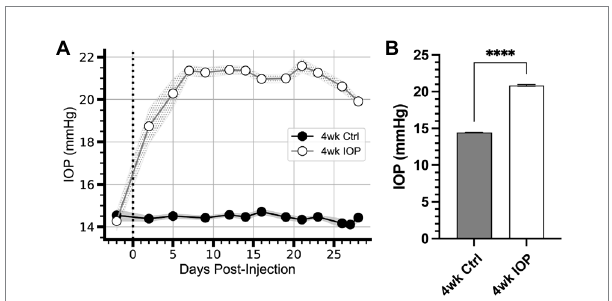
FIGURE 1 IOP elevation due to microbead occlusion of the anterior chamber. (A) Intraocular pressure (IOP) of microbead-injected eyes (4wk IOP) increases rapidly following injection (vertical dotted line) and remain elevated for the duration of the 4 weeks. The IOP of saline-injected eyes (4wk Ctrl) remains unchanged from baseline. Shaded region: ± standard error of the mean. (B) Mean IOP for each eye across all days following microbead injection significantly elevates compared to Ctrl ( p = 0.000046, unpaired t -test). Error bars: ± standard error of the mean. **** p <